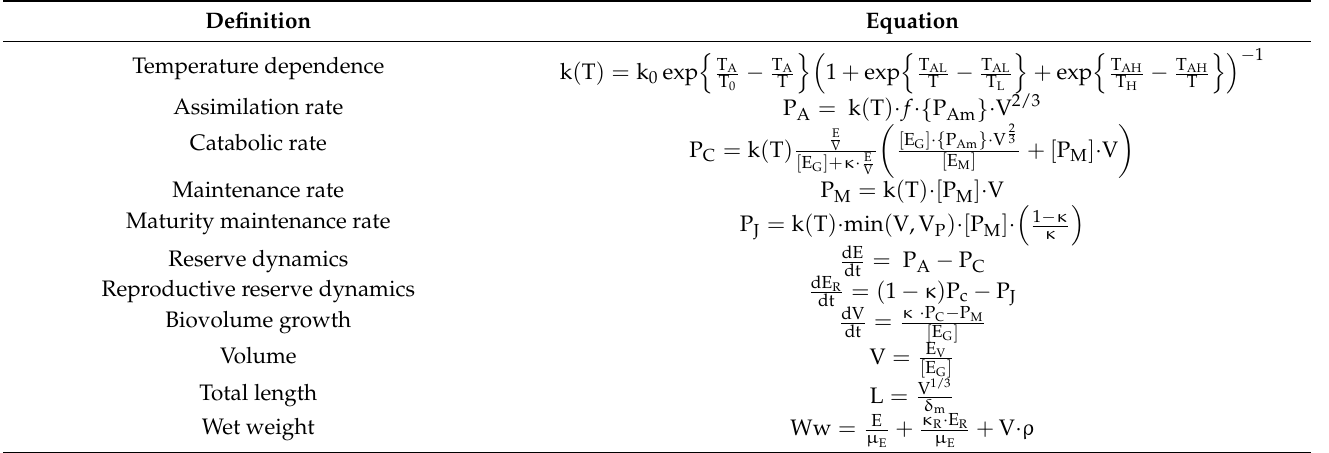
Table 1. Equations describing the energy fluxes in the standard DEB model for kuruma shrimp.